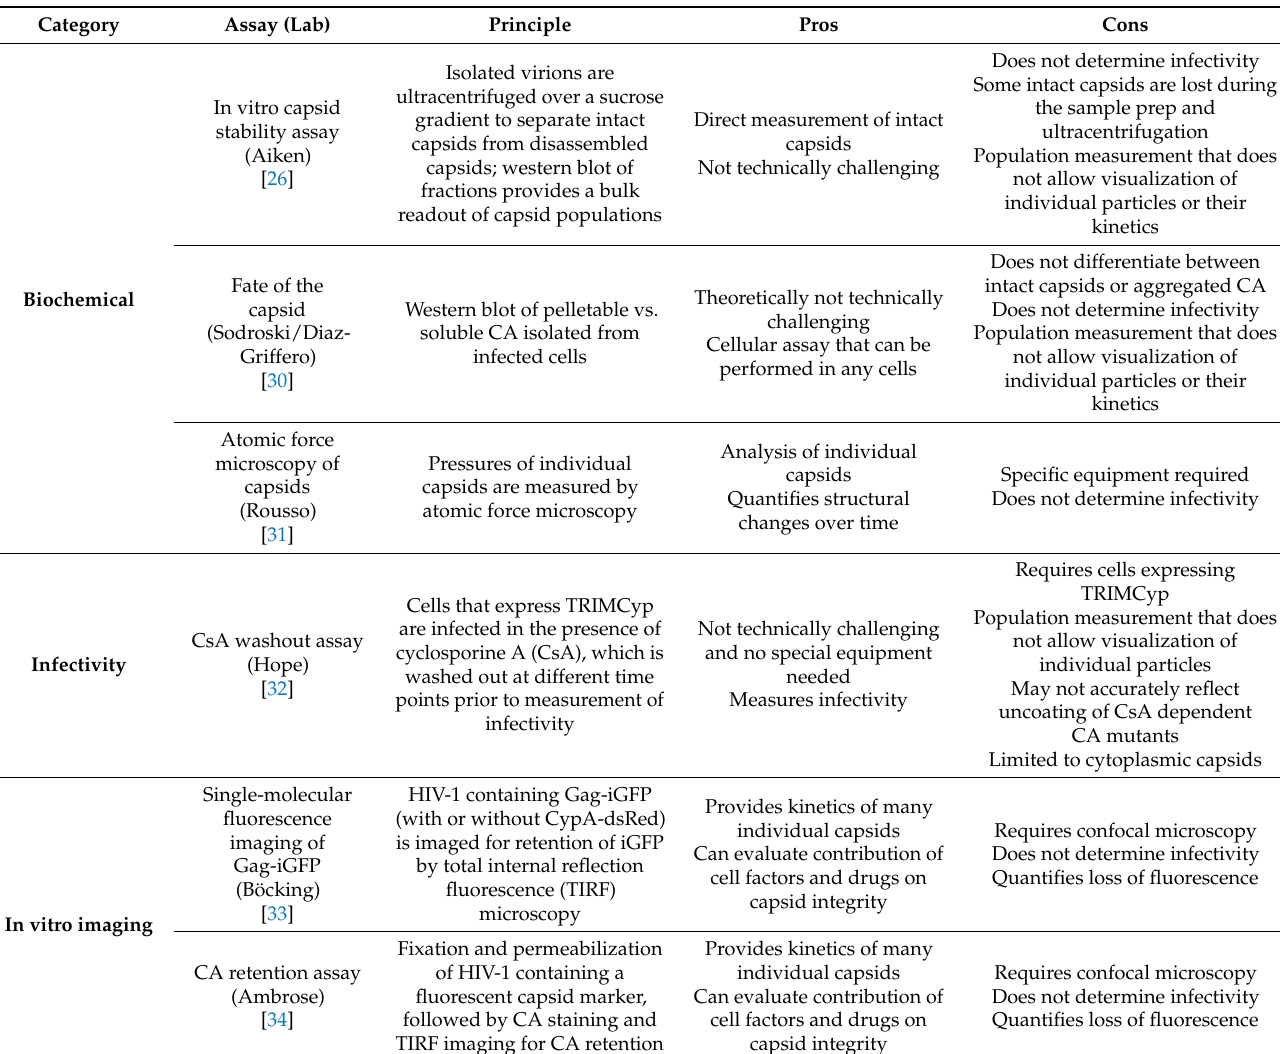
Table 1. Biochemical, in vitro imaging, and infectivity assays to assess HIV-1 capsid uncoating/integrity.